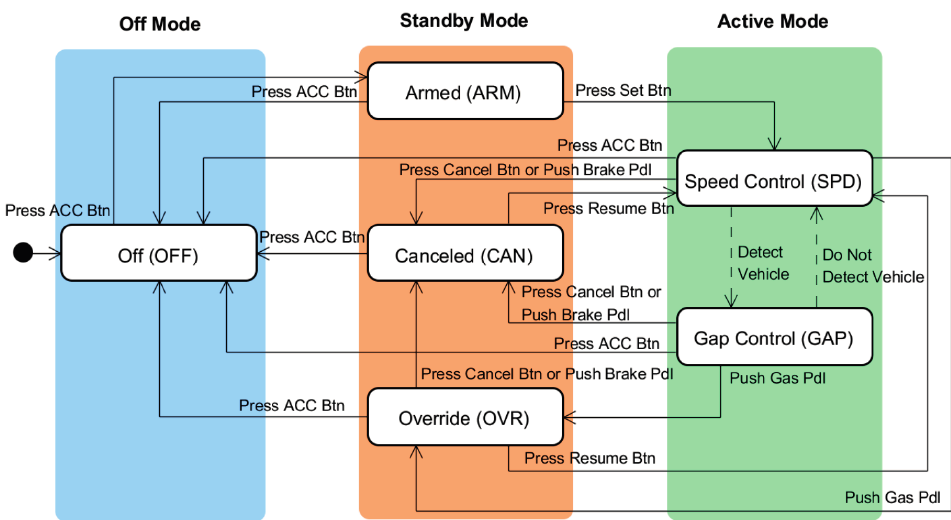
Figure 6. Grouping of the machine model states in the three-mode interface